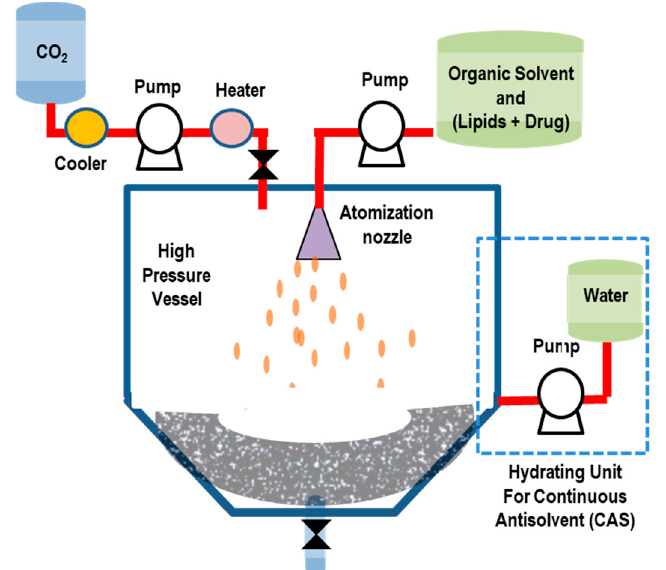
Figure 10. Schematic representation of the SAS method for liposome preparation. The SCF CO 2 is pumped to the top of the high-pressure vessel until the system reaches a constant temperature and pressure. Subsequently, an organic solution containing the lipids and active substance is sprayed (through an atomization nozzle) as fine droplets into the above SCF bulk phase. Liposomes are finally formed in a successive hydration step. In the continuous antisolvent (CAS) method, the addition of the hydration unit allows for the hydration of the lipid suspension in the same autoclave under pressure.